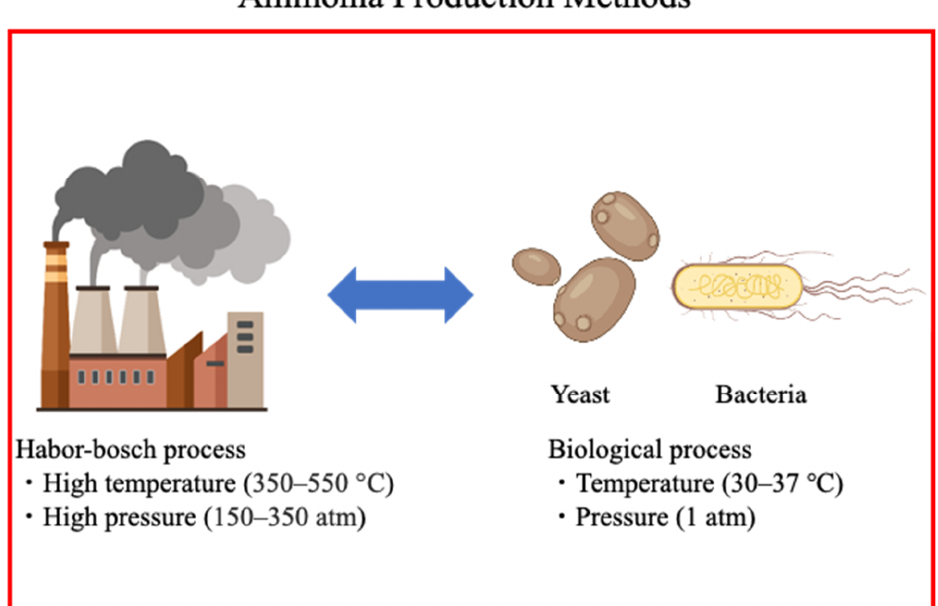
Figure 2. Sustainable ammonia production (created with